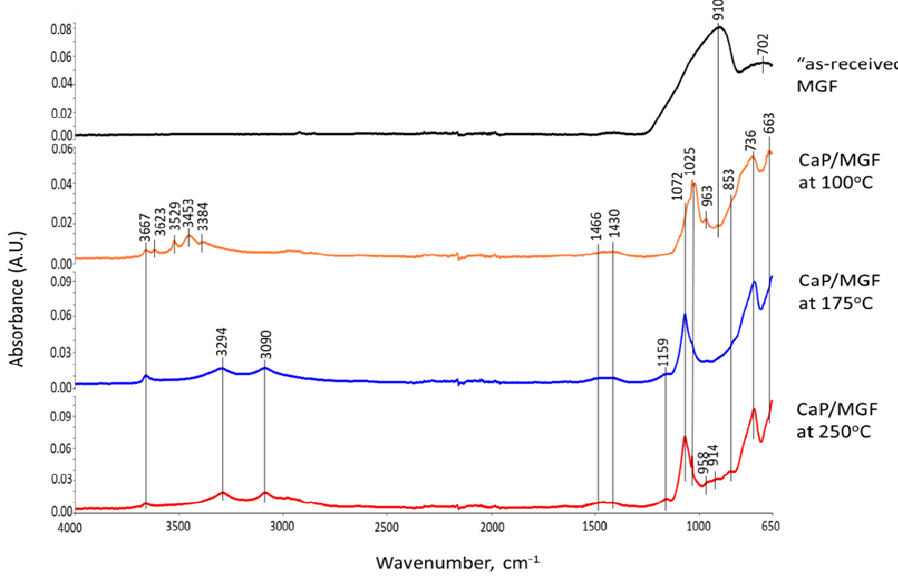
◦ C-autoclaved CaP/MGF